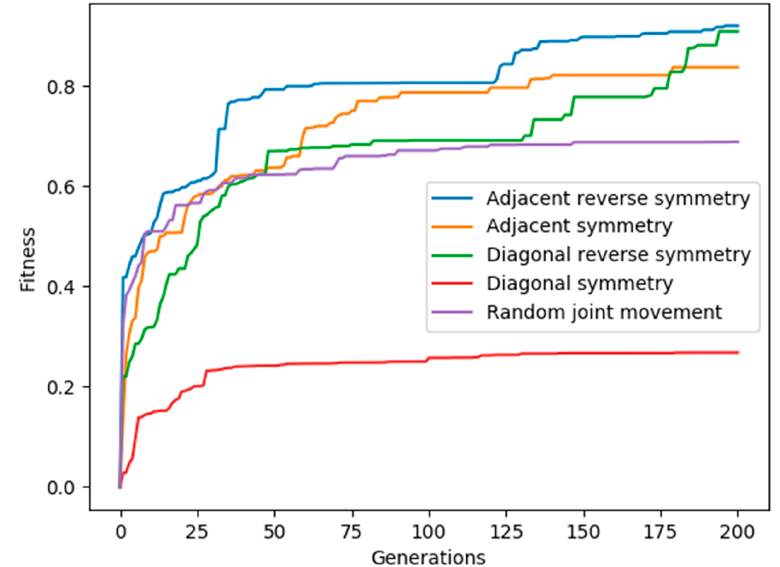
Figure 10. Average fitness values of all the joint symmetries and asymmetries used.